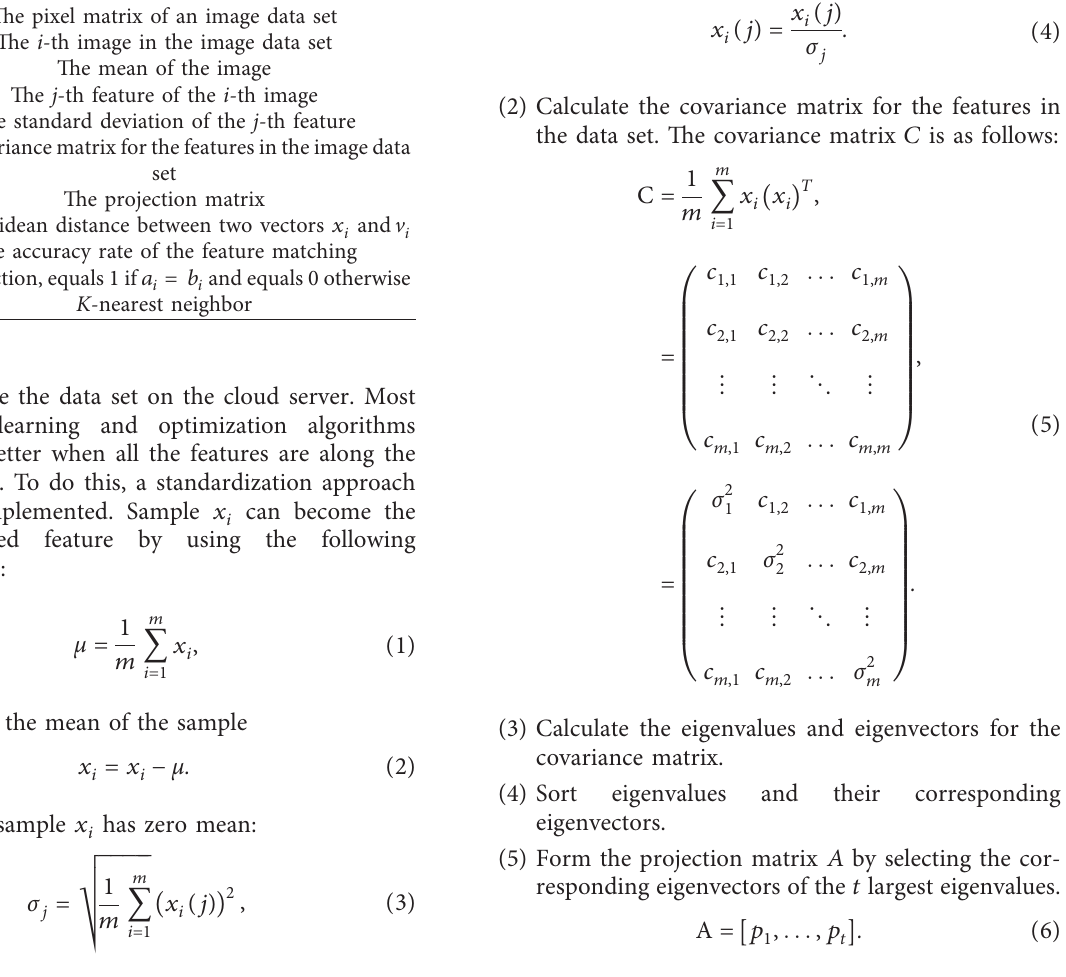
Figure 1: The detailed design of the proposed framework. Table 1: Frequently used symbols. Symbols